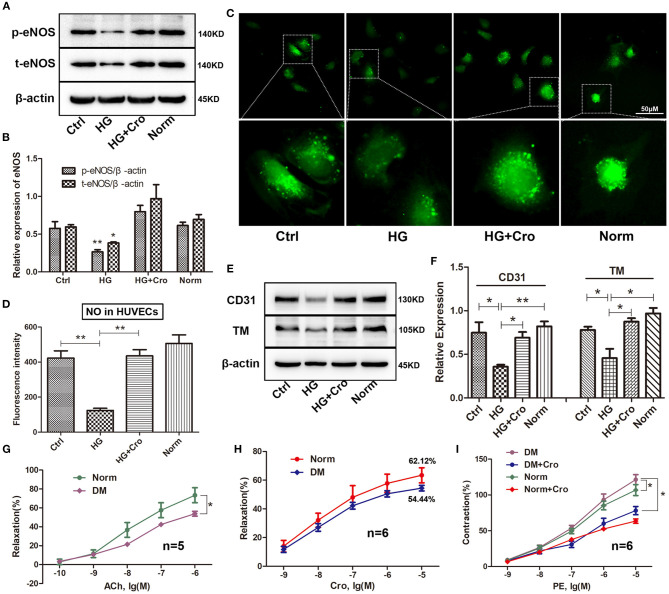
Crocin improves the hyperglycemia-induced endothelial dysfunction. Crocin was used to detect the alterations in the expression of t-eNOS, p-eNOS, CD31, and TM, as well as NO generation in HG-cultured HUVECs. Further, a myograph study was executed to analyze vascular tone after crocin application in diabetic rats. Western blotting showed that crocin suppressed the HG-induced decreases of t-eNOS and p-eNOS (A,B), as well as CD31 and TM (E,F). (C,D) Fluorescence staining determined that crocin reversed the reduction of NO generation by HG. (G) Hyperglycemia reduced the ACh-induced relaxation of artery rings. (H) The maximum vasodilation of diabetic arterial ring was noticeably restored to 88% (relaxation ratio: 54.44/62.12) of the physiological level after crocin treatment. (I) Hyperglycemia elevated the contractive effect of PE on artery rings, while this alteration was remarkably suppressed after pretreatment with crocin for 30 min. Ctrl, control; HG, high glucose; Cro, crocin; Norm, normal glucose; DM, diabetes mellitus; PE, phenylephrine; HUVECs, human umbilical vein endothelial cells; NO, nitric oxide; TM, thrombomodulin; eNOS, endothelial nitric oxide synthase; ACh, acetylcholine; PE, phenylephrine. Myograph data are means ± SEM from five to six different animals and analyzed using unpaired two-tailed Student's t-test and one-way ANOVA followed by Tukey's multiple comparisons test. *p < 0.05, **p < 0.01.